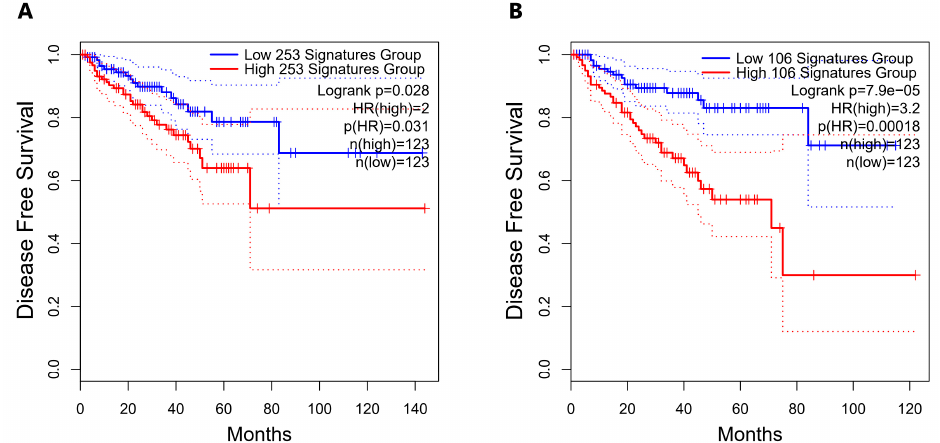
Figure 6. Disease-Free Survival analysis for PRAD-TCGA patients according to the expression of the snc886-3p direct candidate target genes. Disease-Free Survival Kaplan–Meier curve for the expression status of candidate target genes of snc886-3p in PRAD-TCGA was generated using GEPIA2 software [57]. ( A ) 253-snc886-3p direct candidate target gene list. ( B ) 106-snc886-3p direct candidate target gene list. Two groups of patient tumors are compared: percentile 25th expression of the candidate target genes (low expression: blue line) and percentile 75th expression of the candidate target genes (high expression: red line). Hazard Ratio (HR), p (HR) and number of patients in each group are indicated. The dotted lines represent the confidence interval of each group.